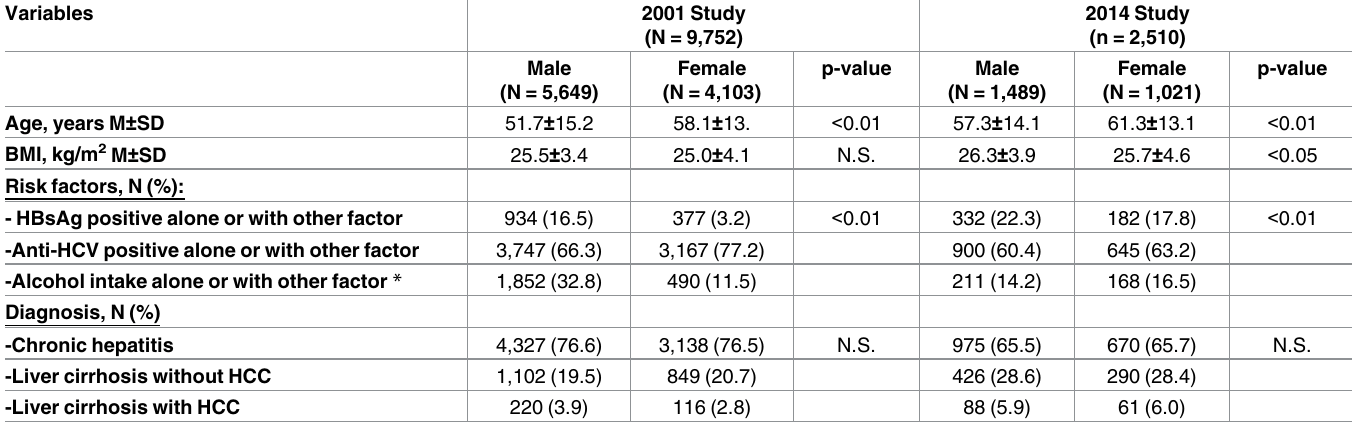
Table 2. Baseline characteristics of 12,262 enrolled subjects by sex and yearsof